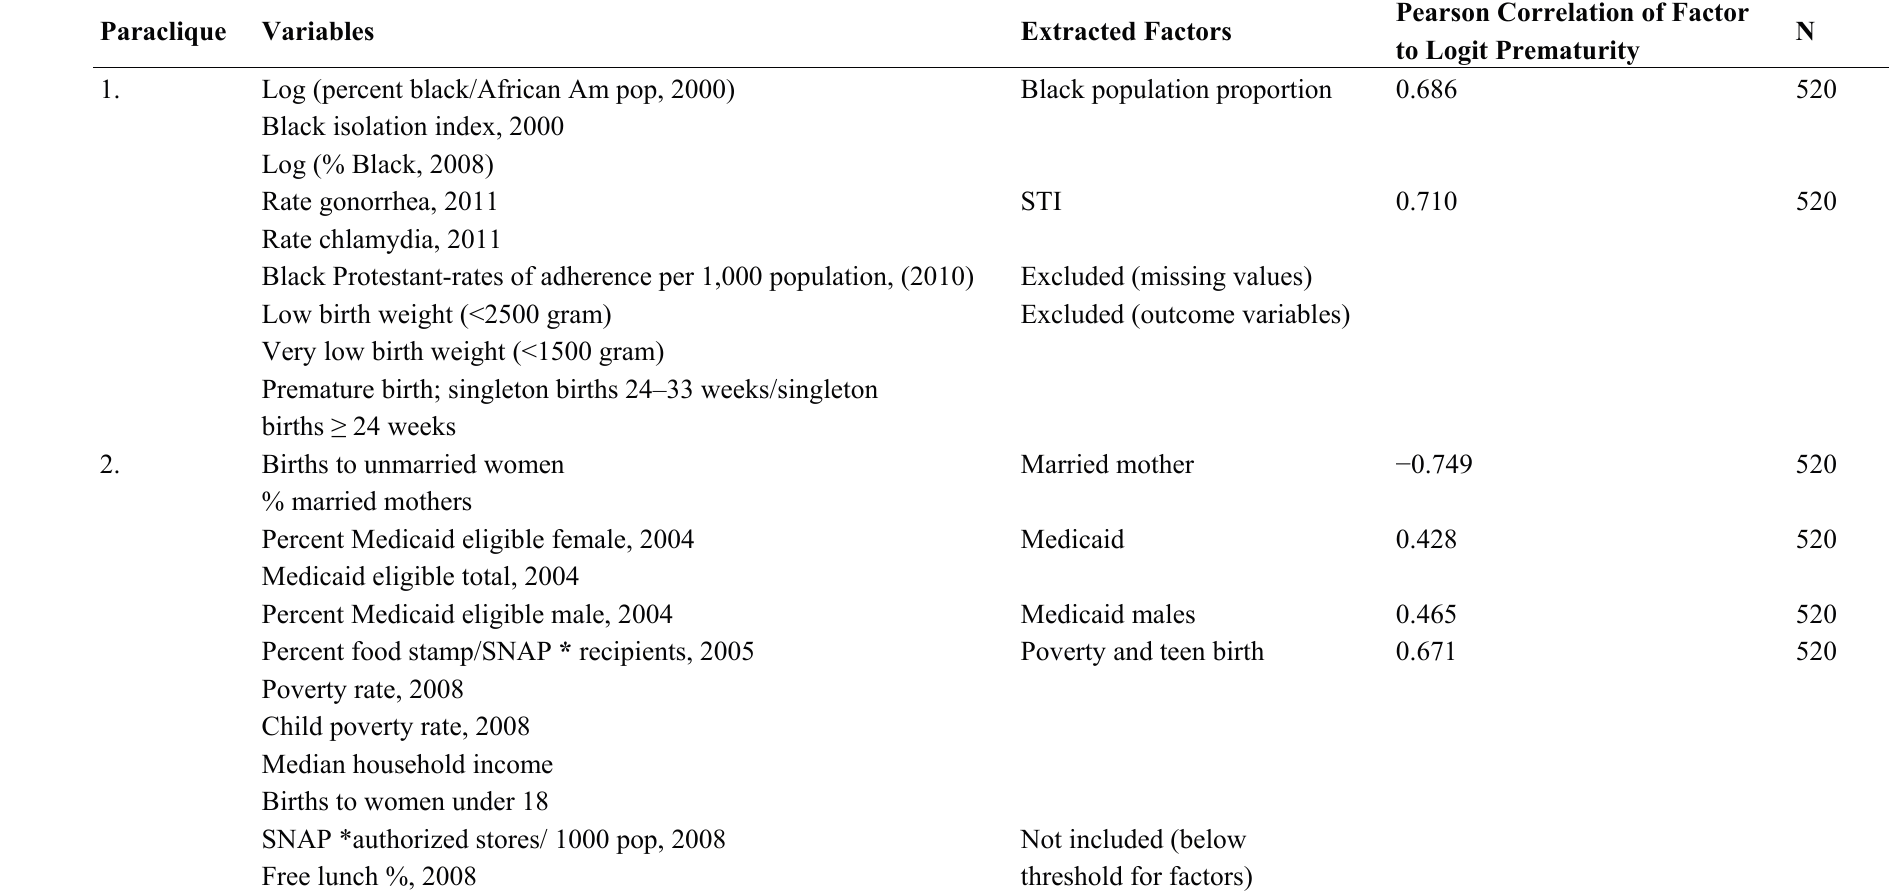
Table 1. Paracliques with median pairwise correlation > 0.38 to prematurity and factors extracted from these paracliques (two paracliques made up of outcome variables alone are not